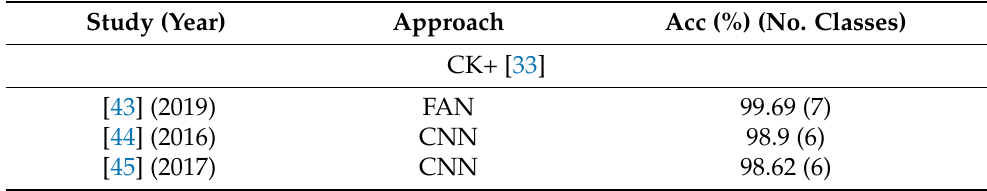
Table 2. FER approaches and results on widely evaluated